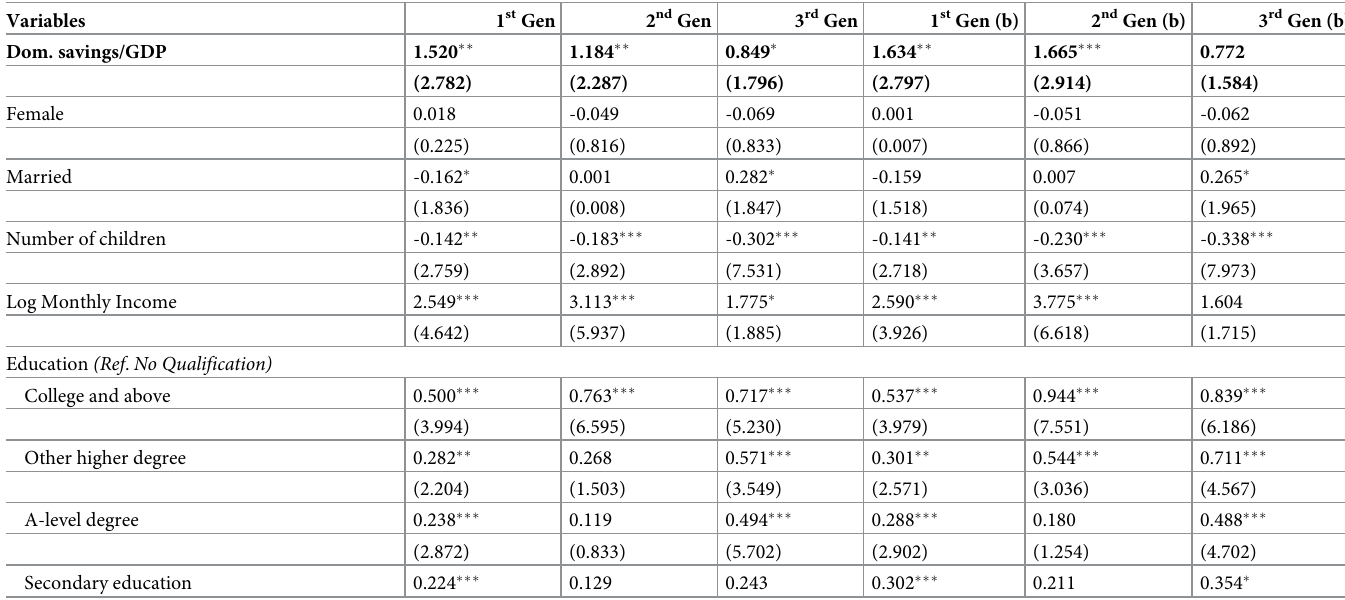
Table 1. ’Log-amount saved’ self-reported amount of (positive)